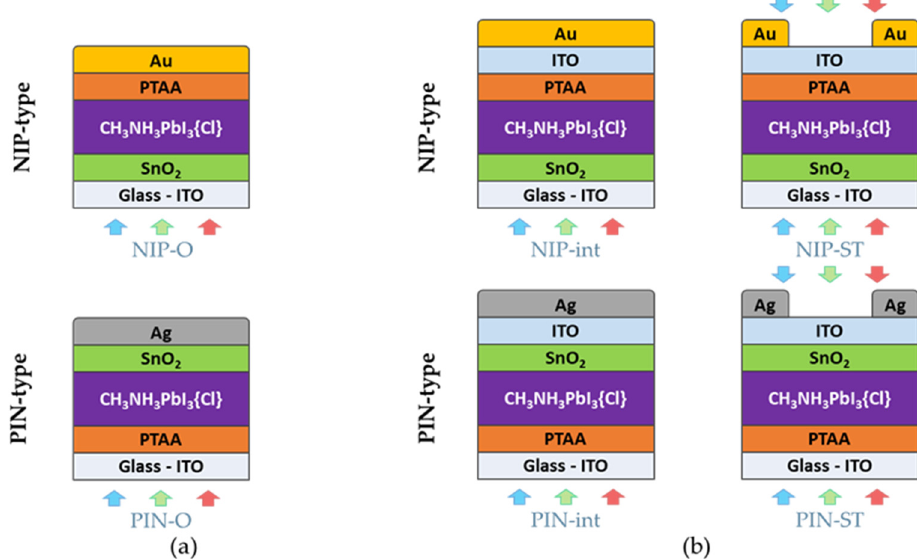
Figure 1. Illustration of the stacks used in this study for both negative -intrinsic- positive ( NIP) and positive -intrinsic- negative (PIN) architectures: ( a ) reference opaque devices (NIP-O and PIN-O); ( b ) their respective intermediary opaque (NIP-int and PIN-int) and semi-transparent devices (NIP-ST and PIN-ST).